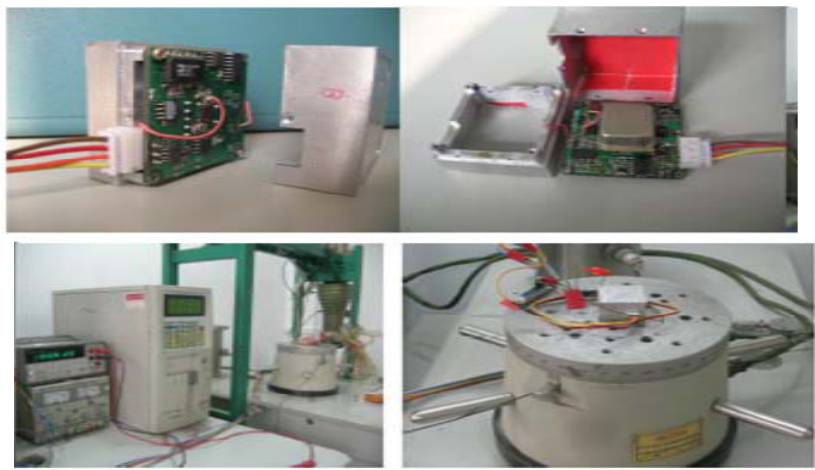
Figure 11. Miniature microgyro